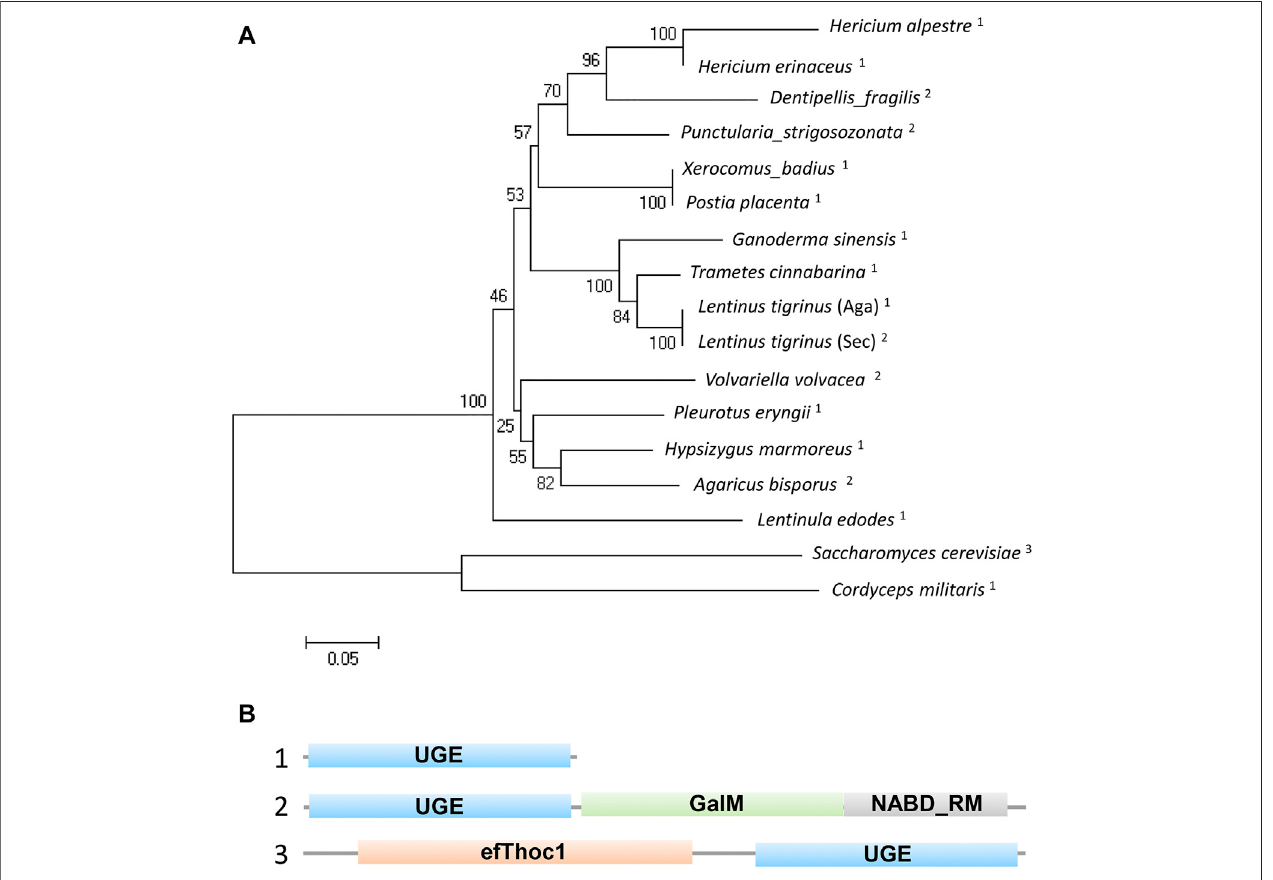
FIGURE1| PhylogeneticandstructuralanalysisofUDP-glucose-4-epimerasesinfungi. (A) PhylogeneticanalysisofUDP-glucose-4-epimerasesoffungiincluding: Hericium erinaceus (DATA S1), H. alpestre (accession no. TFY78463.1), Dentipellis_fragilis (accession no. TFY62748.1), Punctularia_strigosozonata (accession no. XP_009540529.1), Xerocomus_badius (accession no. KAF8559888.1), Postia_placenta (accession no. KAF8559888.1), Ganoderma_sinensis _ZZ0214-1 (accession no. PIL31081.1), Trametes_cinnabarina (accession no. CDO77294.1), Lentinus_tigrinus _(Aga) (accession no. RPD64555.1), Lentinus_tigrinus _(Sec)